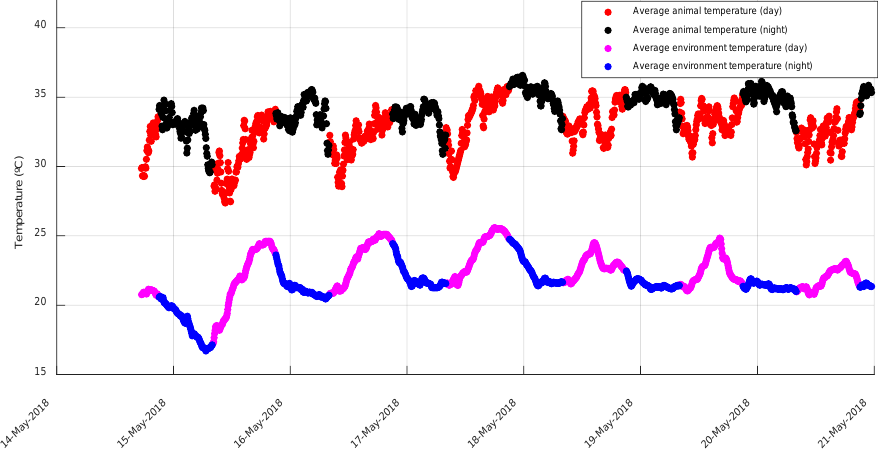
Figure 5. One week detail of the time series of the average temperatures of the environment and animals; the corresponding time and day sections are indicated by different colors.